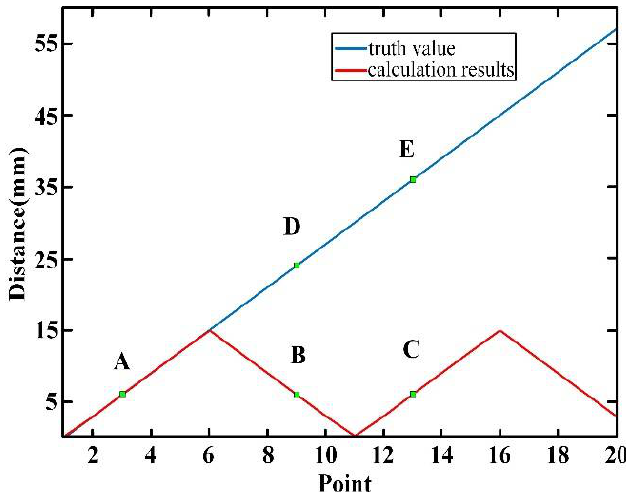
Figure 5. Simulation of non-ambiguity range.